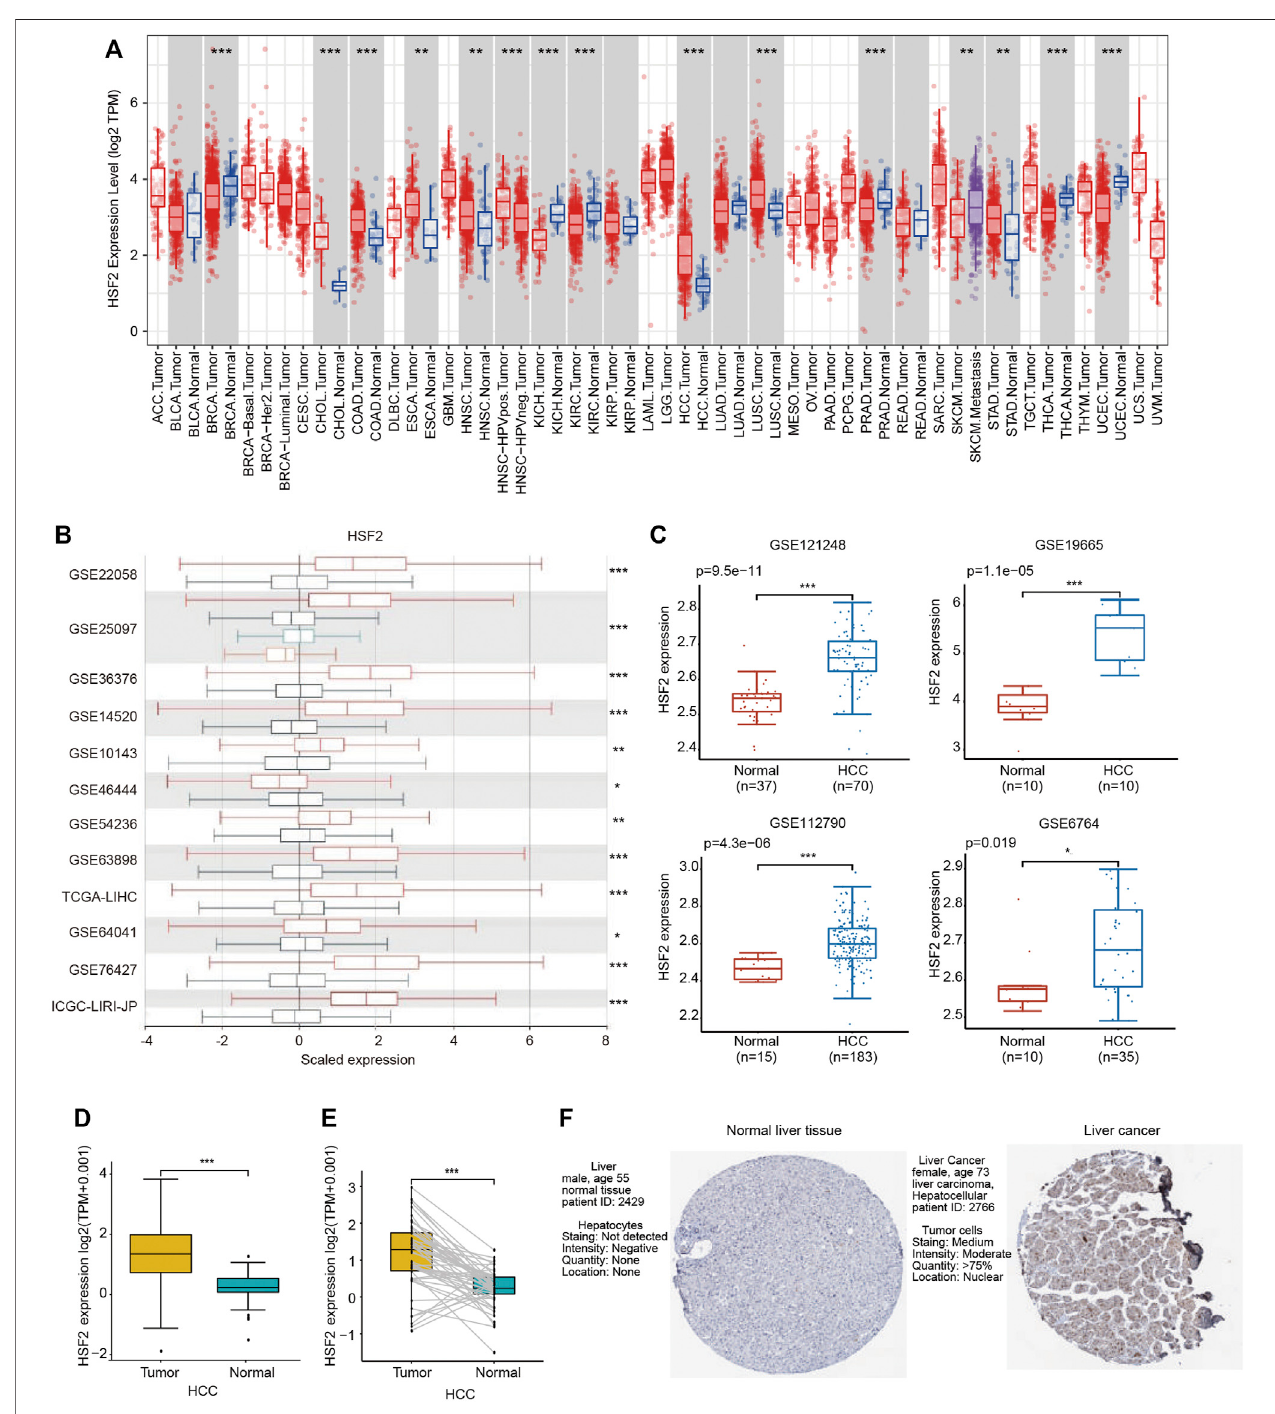
FIGURE 1 | HSF2 expression in HCC. (A) Increased or decreased expression of HSF2 in different types of tumors compared to normal tissues in the TIMER database. (B) Expression of HSF2 in HCC and normal tissues in the HCCDB database. (C) HSF2 expression in HCC (GSE121248, n (cid:1) 70; GSE19665, n (cid:1) 10; GSE112790, n (cid:1) 183; GSE6764, n (cid:1) 35) and normal tissues (GSE121248, n (cid:1) 37; GSE19665, n (cid:1) 10; GSE112790, n (cid:1) 15; GSE6764, n (cid:1) 10) was investigated by analyzingfourGEOdatasets. (D) AnalysisofHSF2expressioninHCC( n (cid:1) 371)andadjacentnormallivertissues( n (cid:1) 50)inTCGAdatabase. (E) HSF2expressionin 50pairsofHCCandadjacentnormaltissuesfromTCGAdatabase( n (cid:1) 50). (F) HSF2expressioninHCCandnormallivertissuesfromtheHPAdatabase.* p < 0.05,** p < 0.01, *** p < 0.01.